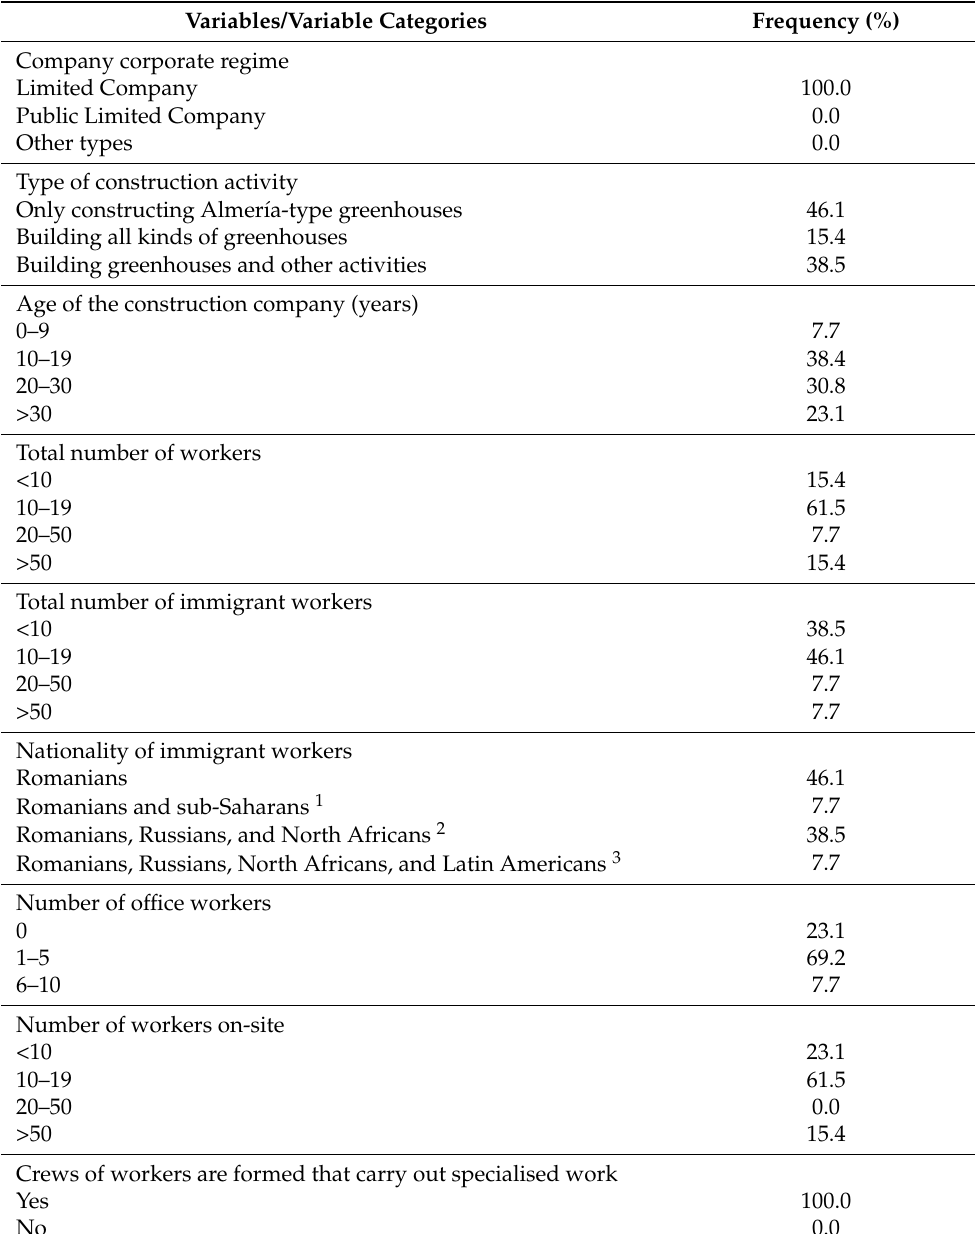
Table A2. Frequency of the company variable